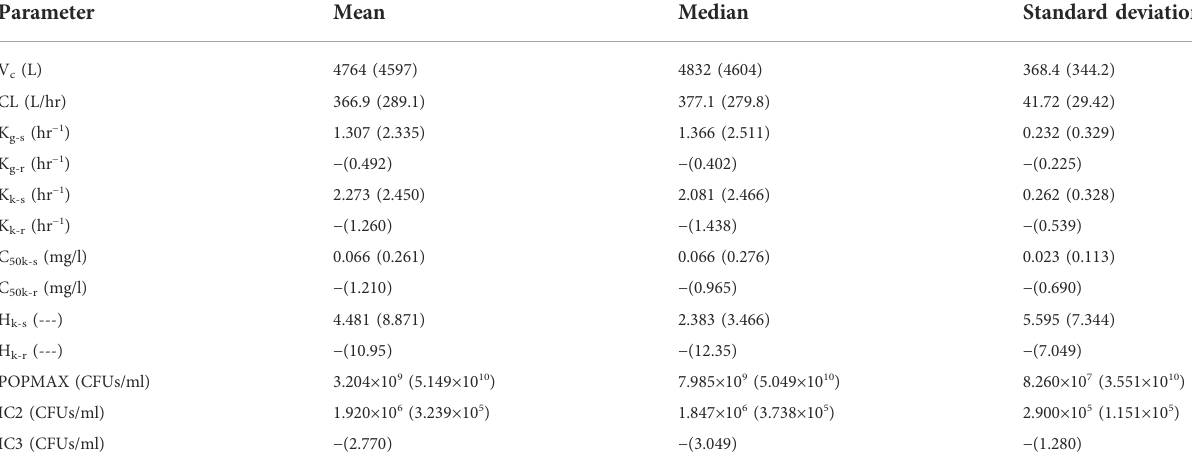
TABLE 2 Mean, median, and standard deviation of the parameter values for the hollow fi ber infection model study, designed based on free lefamulin fraction in human plasma, with Neisseria gonorrhoeae reference strains WHO F and WHO X (in parenthesis).